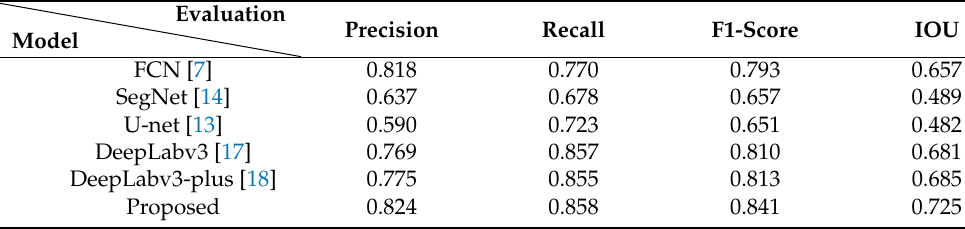
Table 4. Performance between semantic segmentation